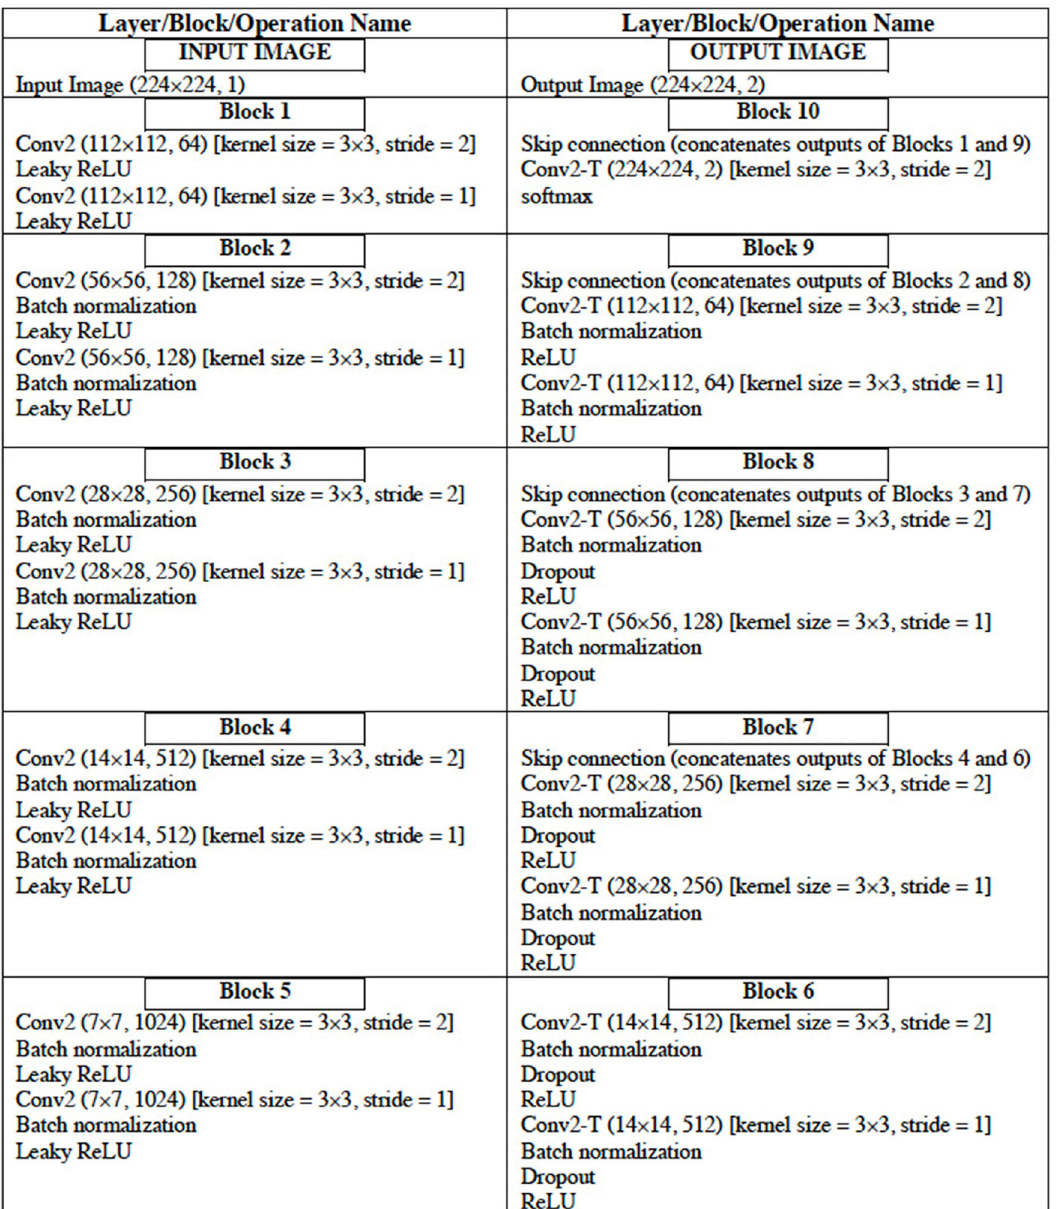
TABLE 6 | Configuration of the UNet DL